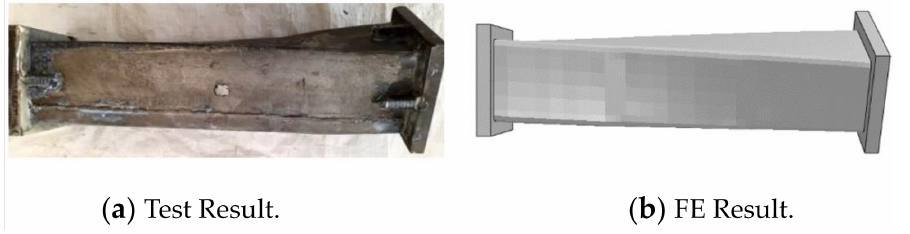
Figure 12. Failure mode of steel